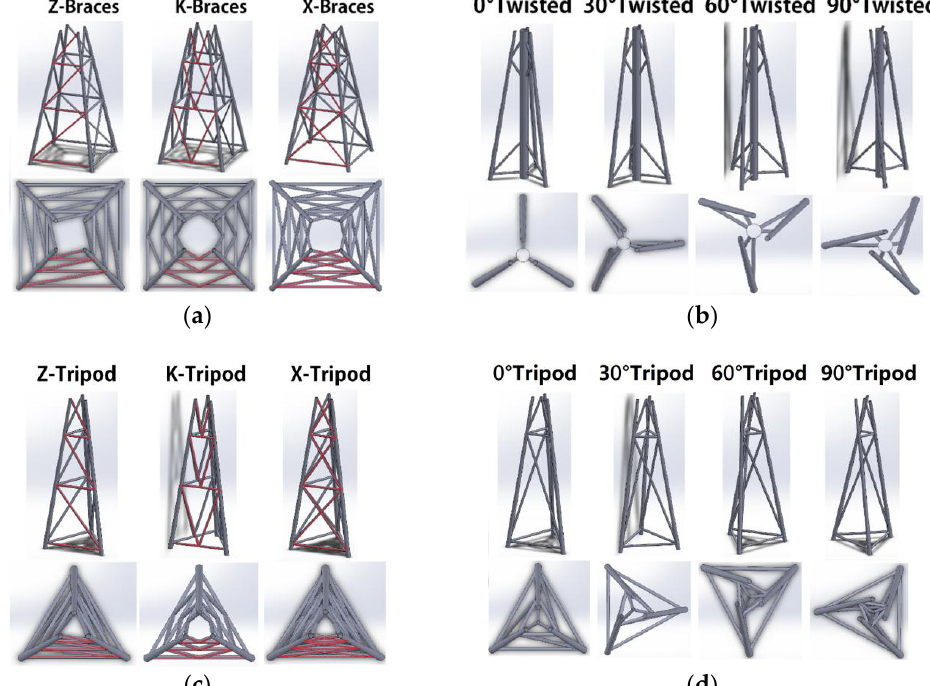
Figure 1. ( a ) Traditional jacket substructures (J-structures): Z-braces (JZ), K-braces (JK) and X-braces (JX); ( b ) twisted jacket substructures (TJ-structures): 0° twisted (TJ0), 30° twisted (TJ30), 60° twisted (TJ60) and 90° twisted (TJ90); ( c ) tripod jacket substructures (PJ-structures): Z-tripod (PJZ), K-tripod (PJK) and X-tripod (PJX); ( d ) twisted-tripod jacket substructures (modified jacket (MJ)-structures): 0° tripod (MJ0), 30° tripod (MJ30), 60° tripod (MJ60) and 90° tripod (MJ90).